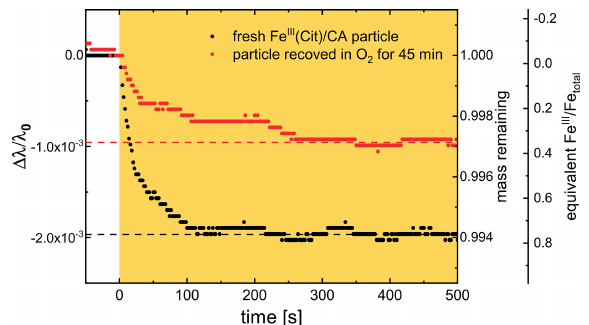
Figure 10. Temporal evolution of two Mie-resonance wavelength shifts and particle mass changes normalized to the wavelength and mass prior to irradiation; the experiment was done at 48% RH and 293.5K. The orange area marks the time with irradiation (473nm, 4Wcm − 2 ). Black: first irradiation with a fresh Fe III ( Cit )/ CA par- ticle in N 2 , red: irradiation in N 2 right after the particle recovered in O 2 for 45min in the dark. Two horizontal dashed lines are indicat- ing the final mass remaining after CO 2 loss to the gas phase. For an explanation of the scaling of the third axis, indicating the equivalent Fe III / Fe tot ratio, see